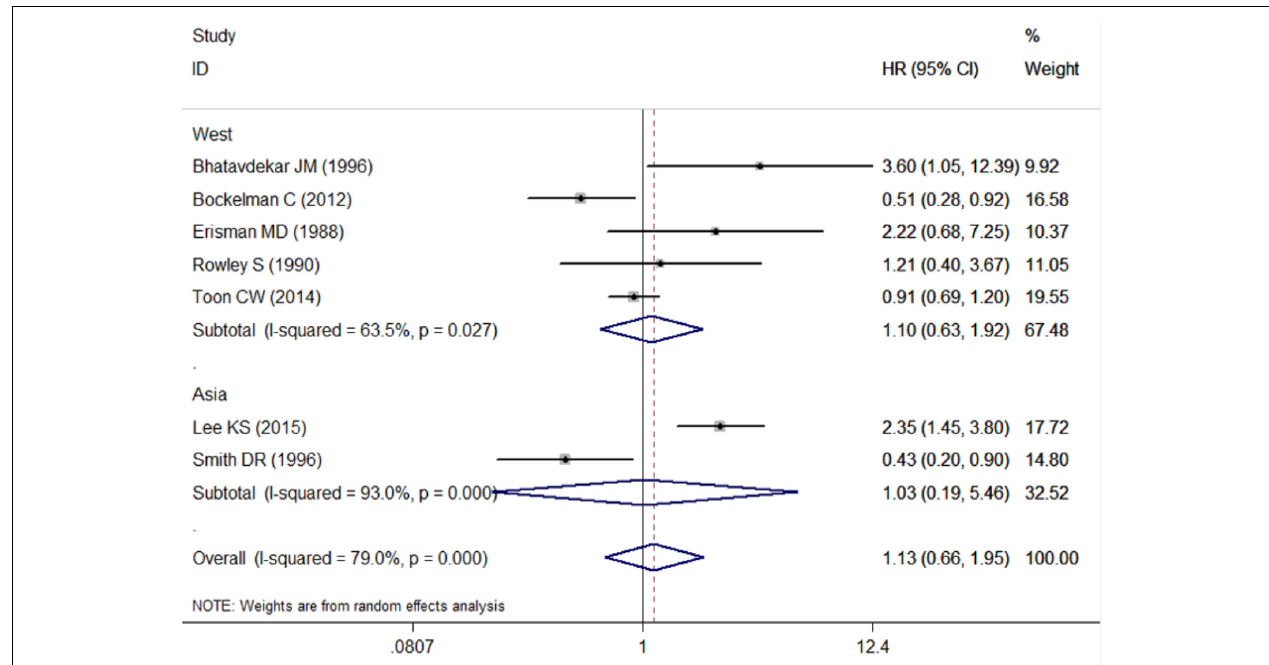
FIGURE 3 | Subgroup analysis for the association between c-Myc and overall survival in the studies from different countries. West, western countries; Asia, Asian countries. TABLE 3 | The results of the meta-analysis (OS). Number of